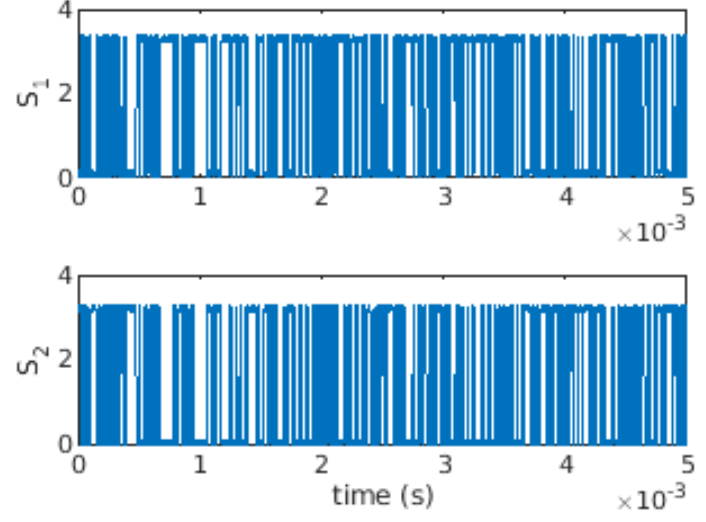
Figure 10. Stochastic signals S 1 and S 2 generated by the control